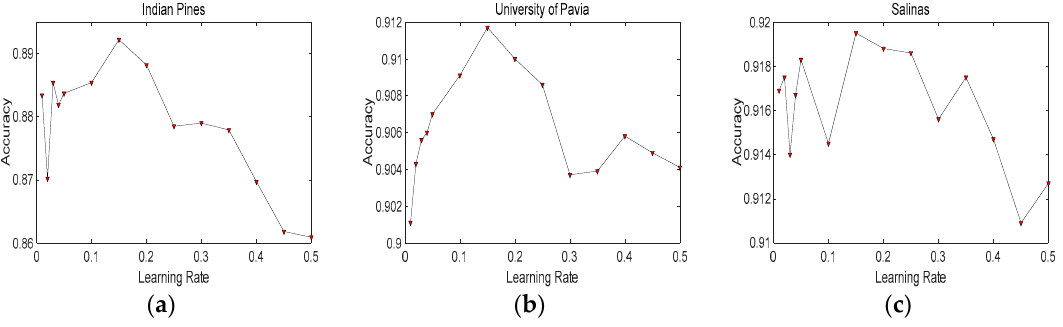
Figure 8. The relationship between accuracies and the learning rates in different datasets: ( a ) Indian Pines; ( b ) University of Pavia; and ( c ) Salinas.